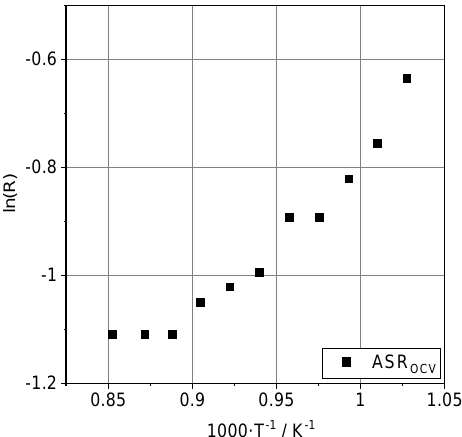
Figure 5. Arrhenius representation (ln(R) → T − 1 ) of the area specific resistance for a ratio of CO 2 :CO of 80:20.